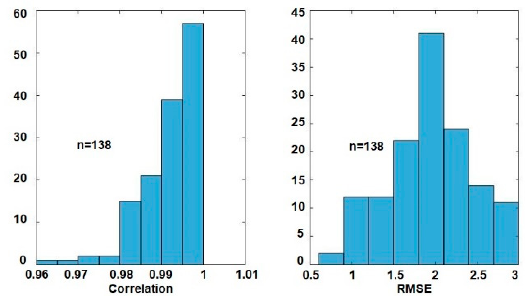
Figure 9. Distributions of correlation and RMSE between θ IMU and θ MAL for vision impaired subjects.